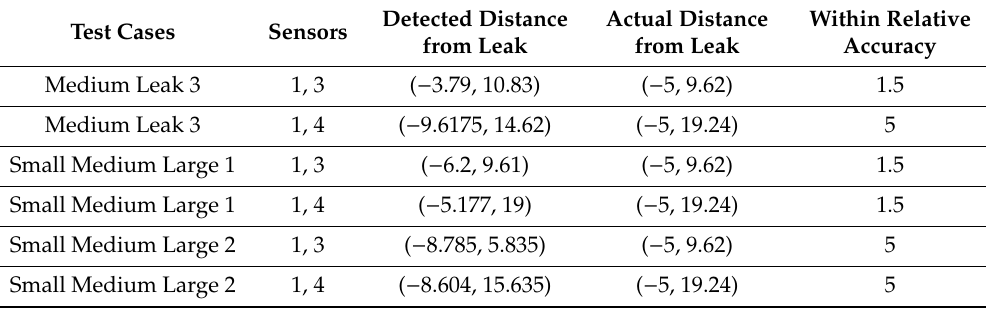
Table 1. Sensors leak location results in